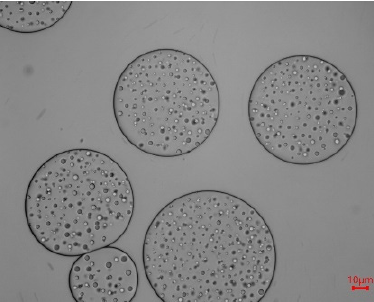
Figure 7. Digital photos of emulsions stabilized by CCP (oil ratio was 50%).